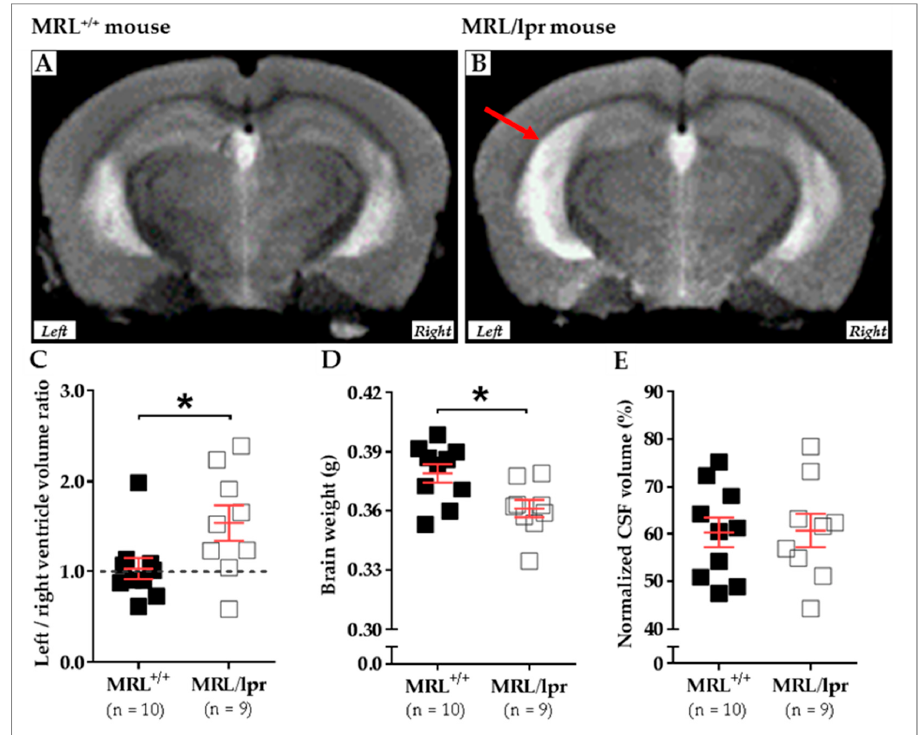
Figure 2. Cerebral abnormalities measured in MRL +/+ and MRL/lpr mice. Conventional mid-axial T2-weighted MRI revealed a dilation of ventricles (red arrow) in 16-week-old female MRL/lpr mice ( B ) as compared to the age-matched counterparts MRL +/+ mice ( A ). In the MRL/lpr strain, this enlargement is more remarkable on the left side, as revealed by analysis of the right/left ventricle volume ratio ( C ). Furthermore, a significant loss of brain weight was detected in these mice ( D ), even if the normalized volume of CSF did not show significant difference between both strains ( E ). Statistics: All data were analyzed with unpaired t test, and significance was defined as p < 0.05 (*) Errors bars are mean standard deviation. Sample size is indicated as n. Abbreviations: CSF, cerebrospinal fluid; lpr, lymphoproliferation; MRI, magnetic resonance imaging; MRL, Murphy Roths